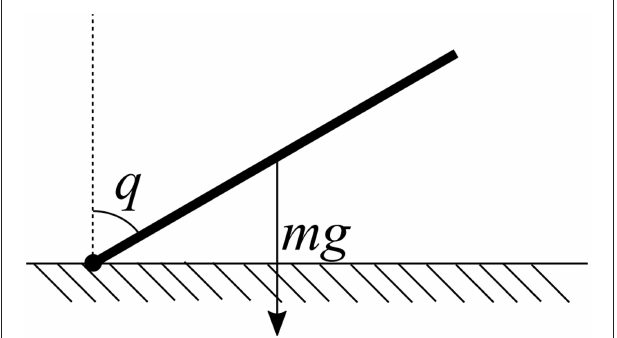
FIGURE 1 | A simple example of a physical embodiment for control. In order to hold the joint q at a desired angle q d , a force must be applied to counteract the pull of gravity. The magnitude of this force is a function of q which can be